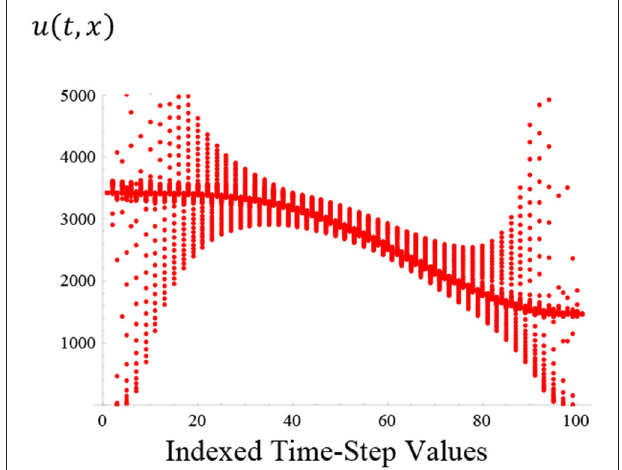
FIGURE 4 | A similar sinusoidal solution to that illustrated in Figure 3A , again with frequency ω ∼= 6.412, of the shock-wave of velocity, u ( t , x ) , this time shown to propagate with respect to the indexed time-step values up to 1s at the 100th position (or the 100th point on the graph). A sharper graph may be obtained by reducing not only the time-period, but also the time-step and the count for this scenario.